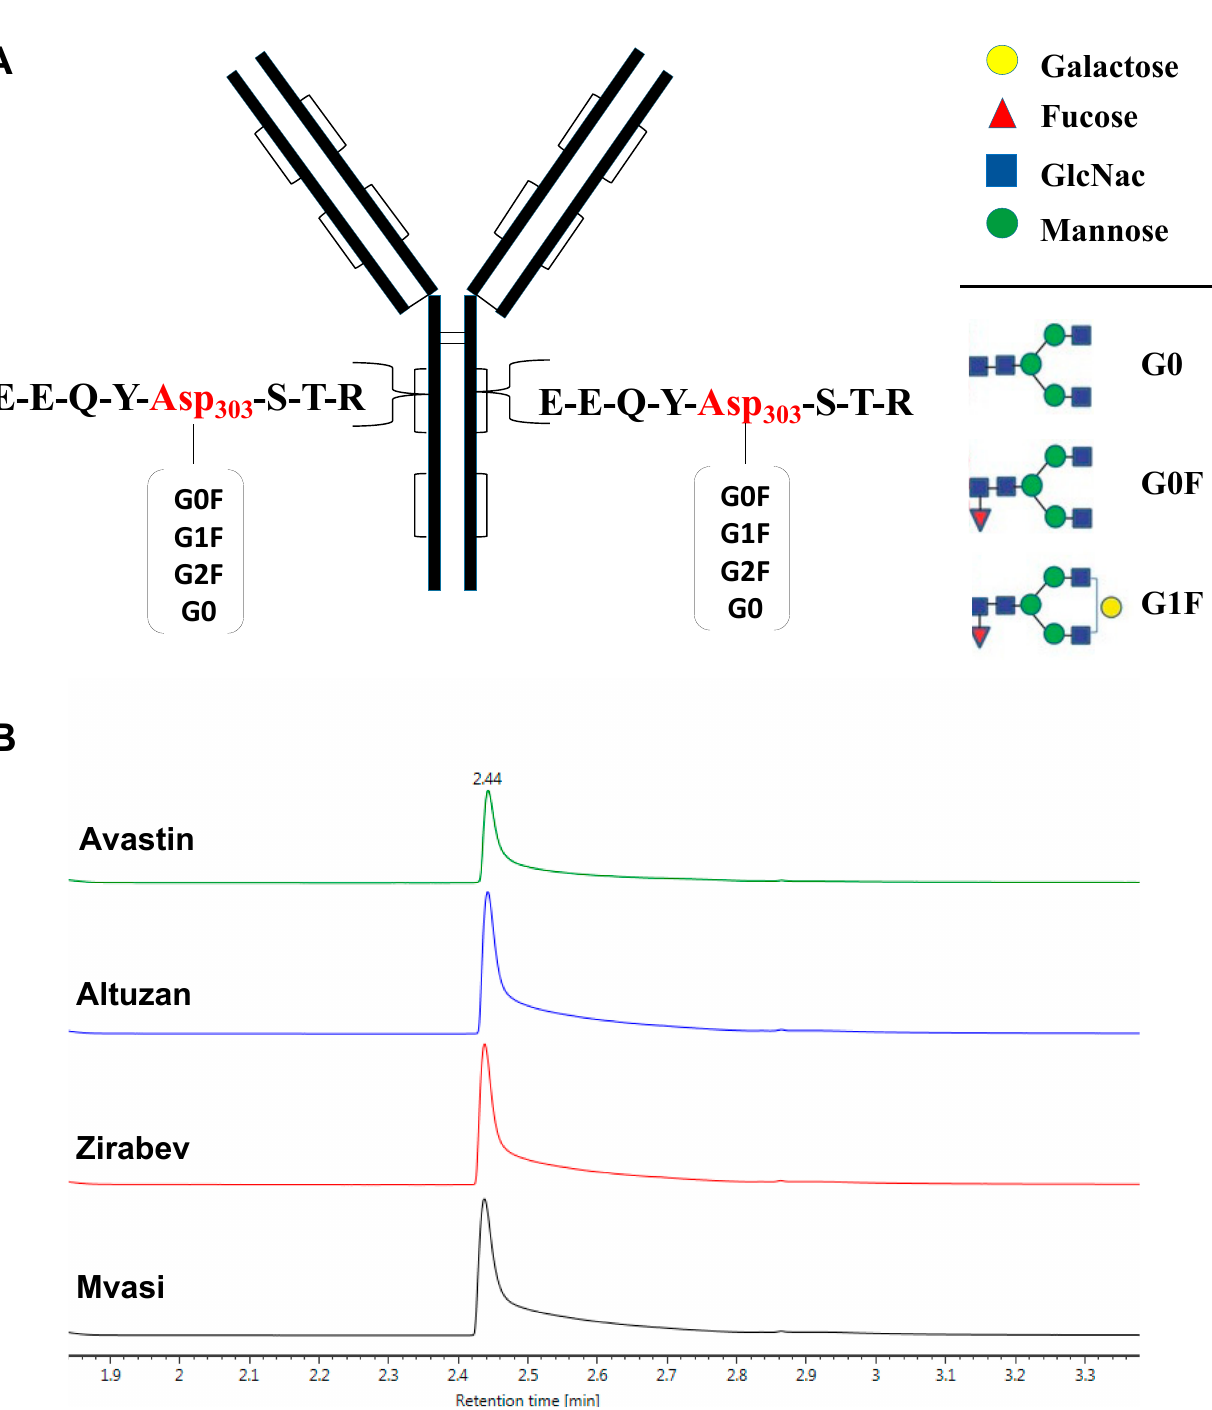
Figure 1. Intact Protein Analysis of AVT, ALT, ZIR, and MVA. ( A ) Schematic illustration of beva- cizumab glycosylation site and main glycans. ( B ) Overlay representation of UV chromatograms of